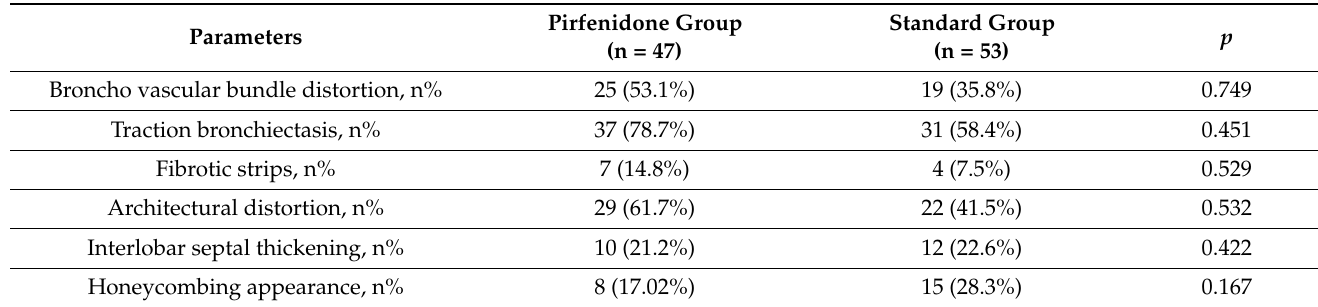
Table 3. Initial CT findings indicating pulmonary fibrosis features following cytokine storm in both groups.